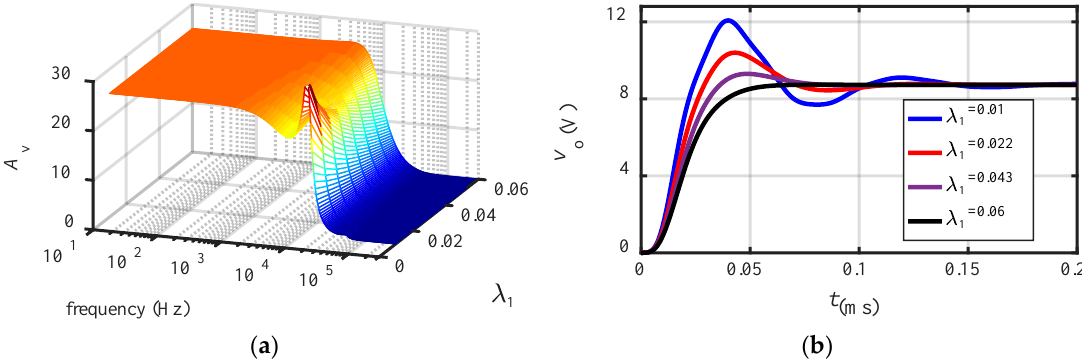
Figure 8. Effect of capacitor current i C feedback on damping of fourth-order class-D amplifier ( a ) closed- loop frequency response for different λ 1 and ( b ) step response for different λ 1 .